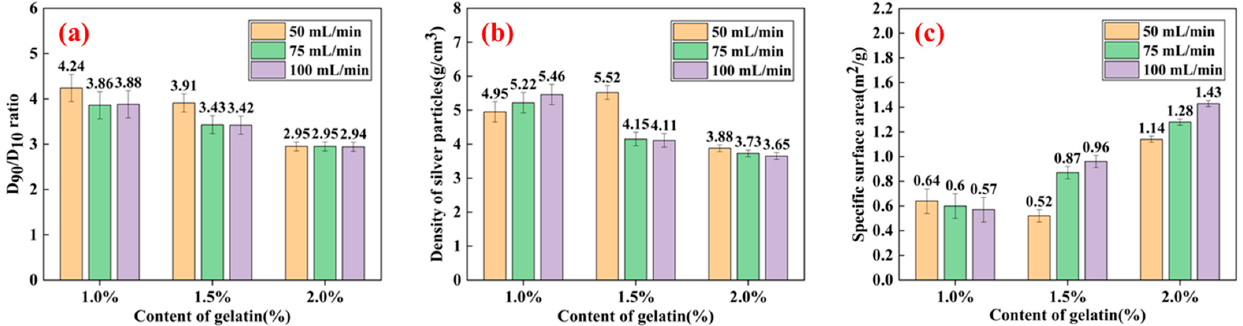
Figure 12. Properties of the silver powders prepared using different gelatin additions and jet flow rates. ( a ) D 10 /D 90 ; ( b ) density of silver particles; and ( c ) specific surface area. A larger D 90 /D 10 ratio indicates a wide particle size distribution and low dispersion [30]. The D 90 /D 10 ratio of the six samples was low, and the greatest value achieved was